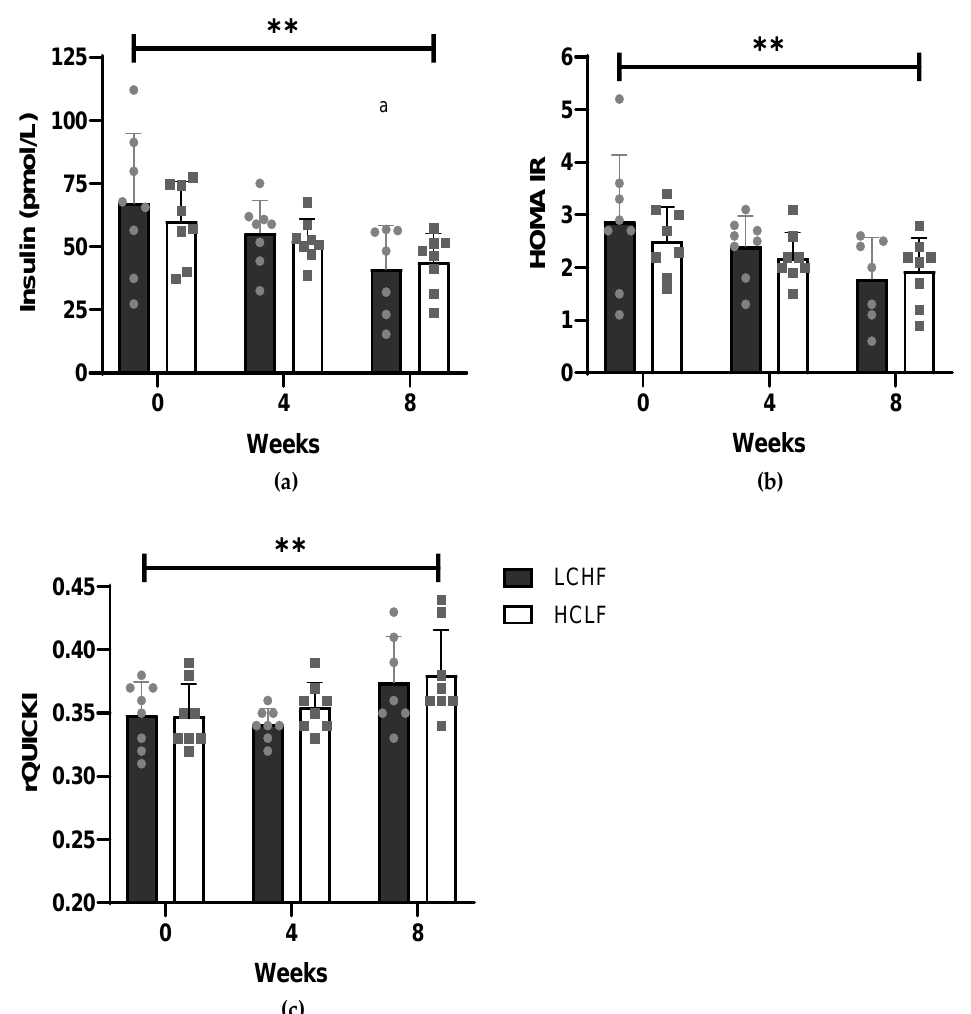
Figure 2. The effect of a LCHF ( n = 8) and HCLF diet ( n = 8) for 8 weeks on markers of insulin resistance. ( a ) The effect of a LCHF and HCLF diet on fasting insulin concentrations. ( b ) The effect of a LCHF and HCLF diet on HOMA IR. ( c ) The effect of a LCHF and HCLF diet on rQUICKI. The grey symbols represent individual responses of the LCHF diet (circle) and HCLF diet (square). HCLF, high carbohydrate low fat; HOMA IR, homeostatic model of insulin resistance, LCHF, low carbohydrate high fat; rQUICKI, revised Quantitative Insulin sensitivity Check Index. The straight line represents the effect of time from the 2 × 3 mixed ANOVA (** p < 0.01), a p < 0.05, denotes significantly different to week 0.